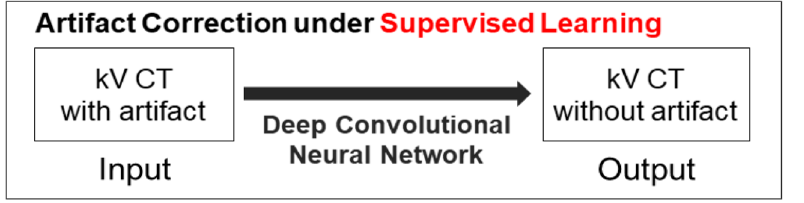
Figure 1. Difficulty of artifact correction by deep learning under supervised learning: artifact-free kV CT matching against artifact-containing kV CT image is not